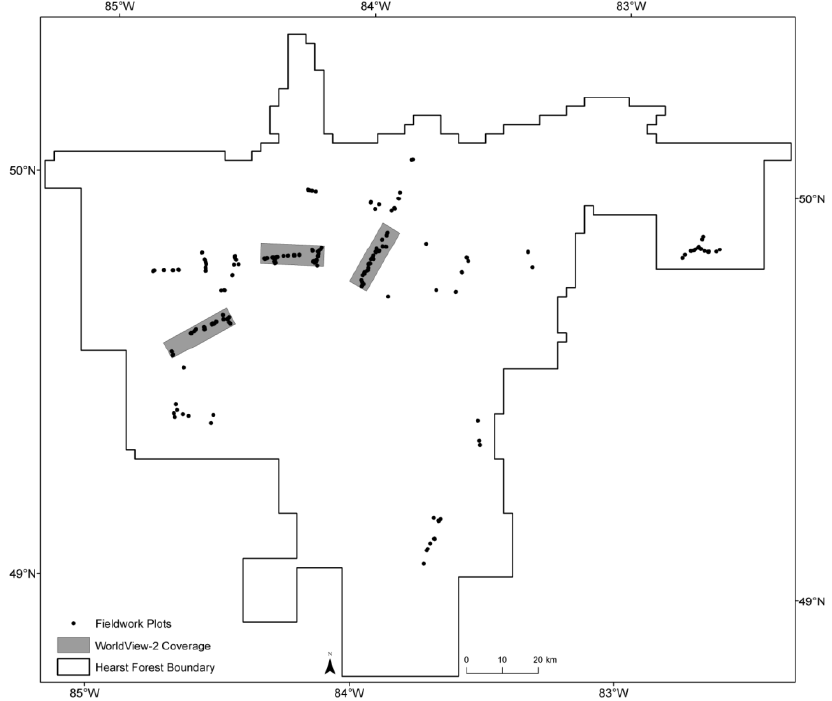
Figure 3. WorldView-2 satellite image coverage in the Hearst Forest.